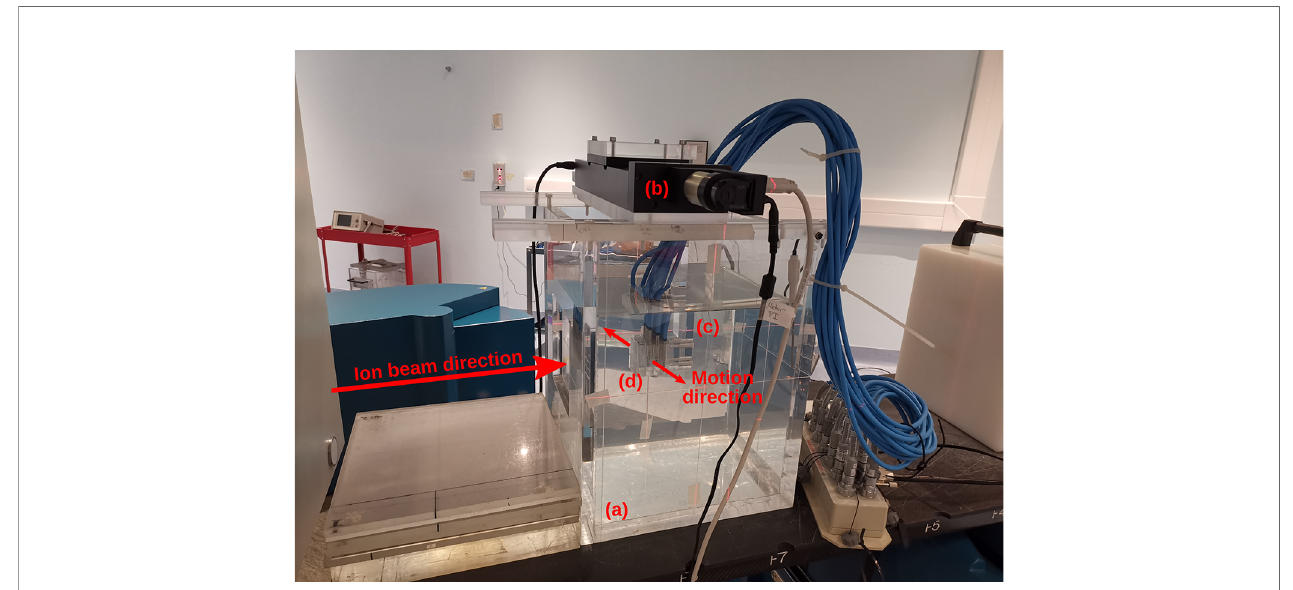
FIGURE 1 | Experimental setup for patient-speci fi c quality assurance (PSQA) measurements with (A) a water tank and (B) a linear stage mounted on top. The linear stage is programmed to move a variety of attachments in periodic, respiratory-like motion patterns. Here, (C) a holder with (D) 12 small-sized ionization chambers (IC) inserted inside is attached. This IC holder aligns with the isocenter markings on the water tank phantom, which is fi lled with